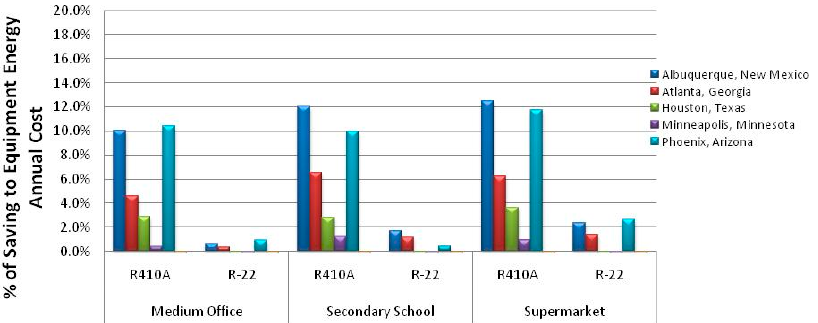
Figure 13. Percentage of savings due to pre-cooling relative to no pre-cooling at all ambient temperatures. Wet bulb efficiency = 0.7, equipment COP = 5.